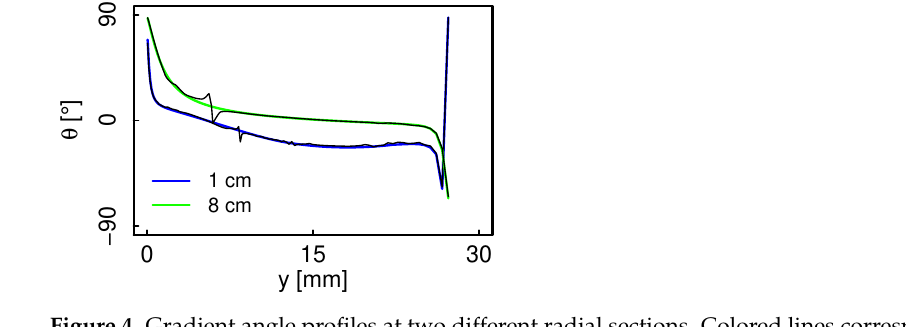
Figure 4. Gradient angle profiles at two different radial sections. Colored lines correspond to ∇ Z , black lines are ∇ CO 2